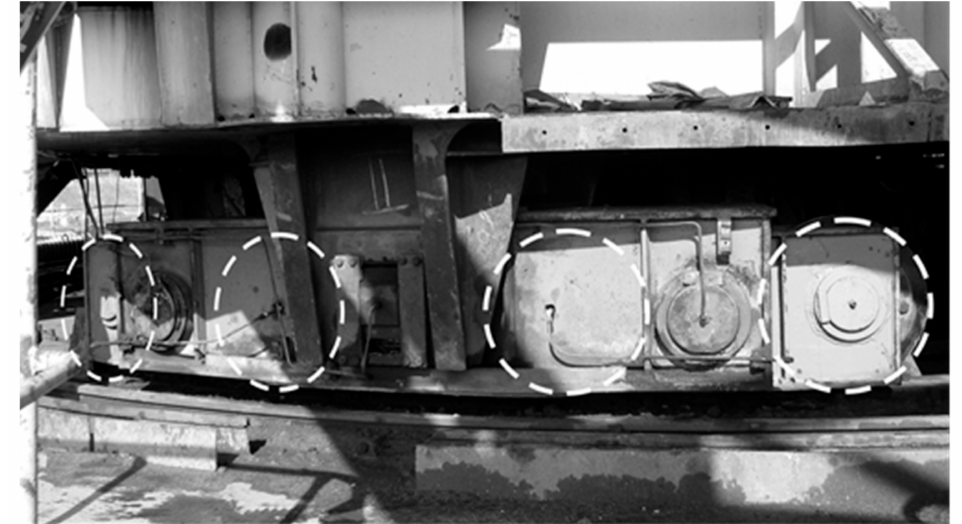
Figure 10. Wheeled bogies on a rail track in the tested bucket-wheel excavator.